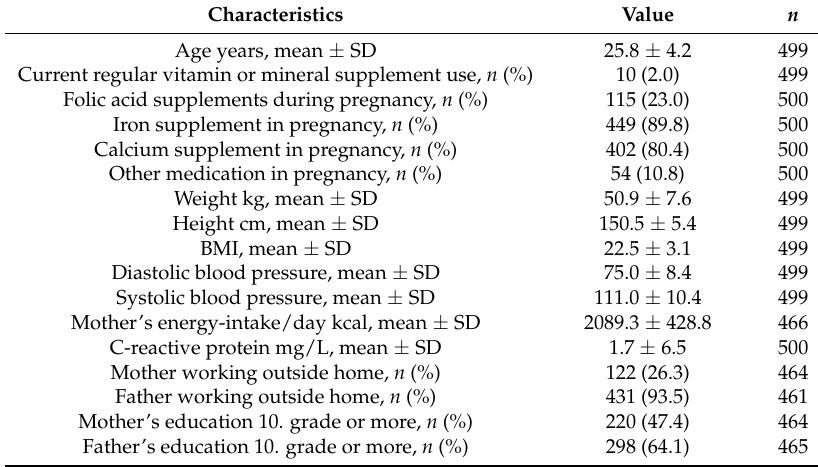
Table 2. Mother/(parent) characteristics in a nutritional survey in mother and infant pairs in Bhaktapur,